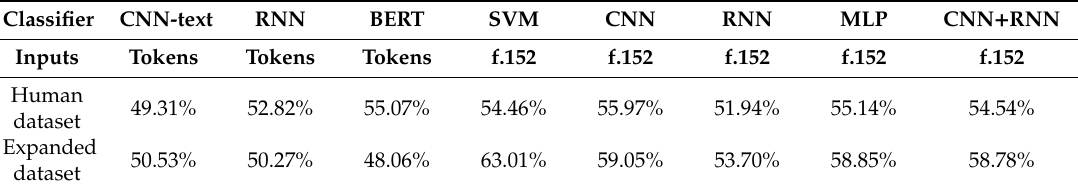
Table 7. Comparing feature- and text-based classifiers. CNN: convolutional neural network,